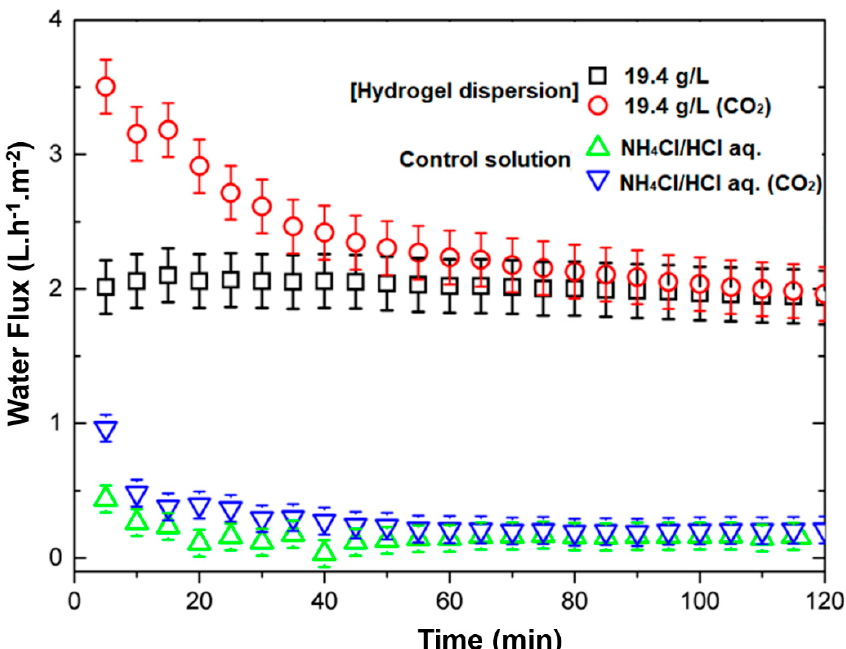
Figure 8. Generated water fluxes in two hours of FO tests of hydrogel dispersions and controls with and without continuous CO 2 bubbling in draw tanks. Black squares: 19.4 g·L − 1 hydrogel dispersion (initial pH = 3.07 and conductivity = 2.85 mS·cm − 1 ) without CO 2 bubbling. Red circles: Freshly prepared 19.4 g·L − 1 hydrogel dispersion with CO 2 bubbling—0.1 L·h − 1 . Green triangles: NH 4+ Cl − /HCl